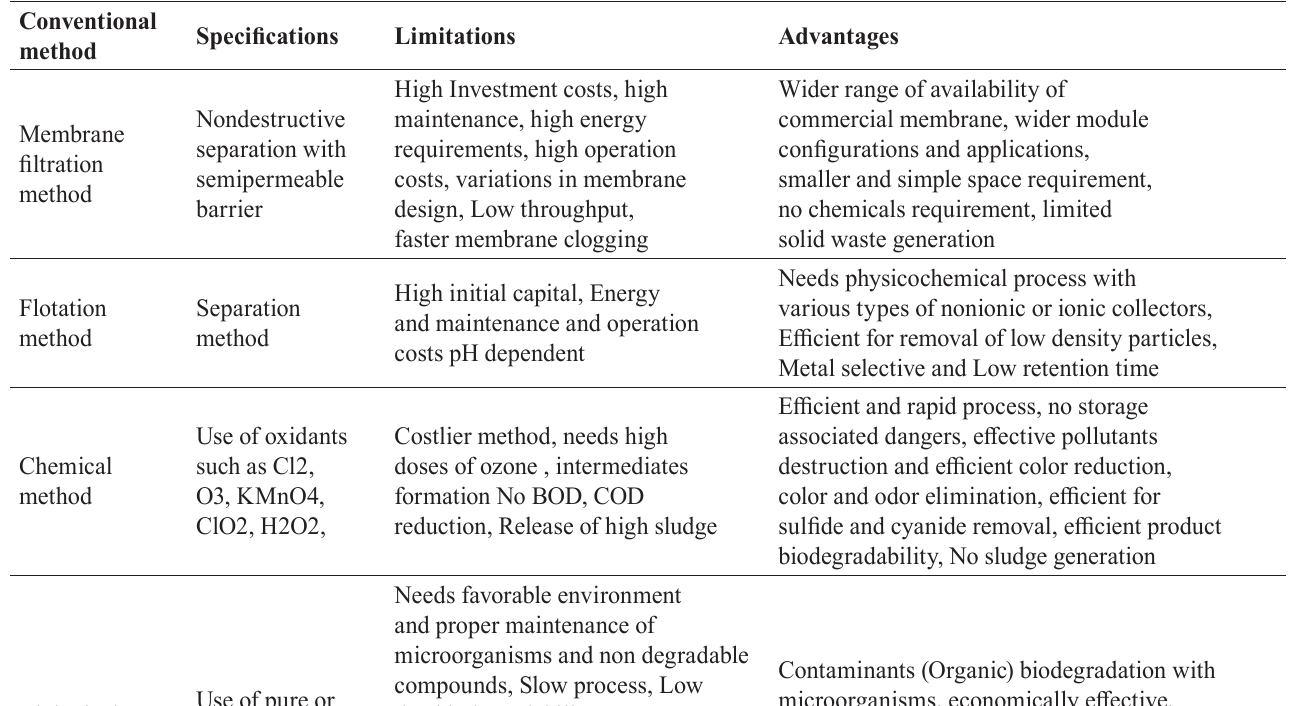
TABLE II - Summary of conventional and traditional methods of wastewater treatment